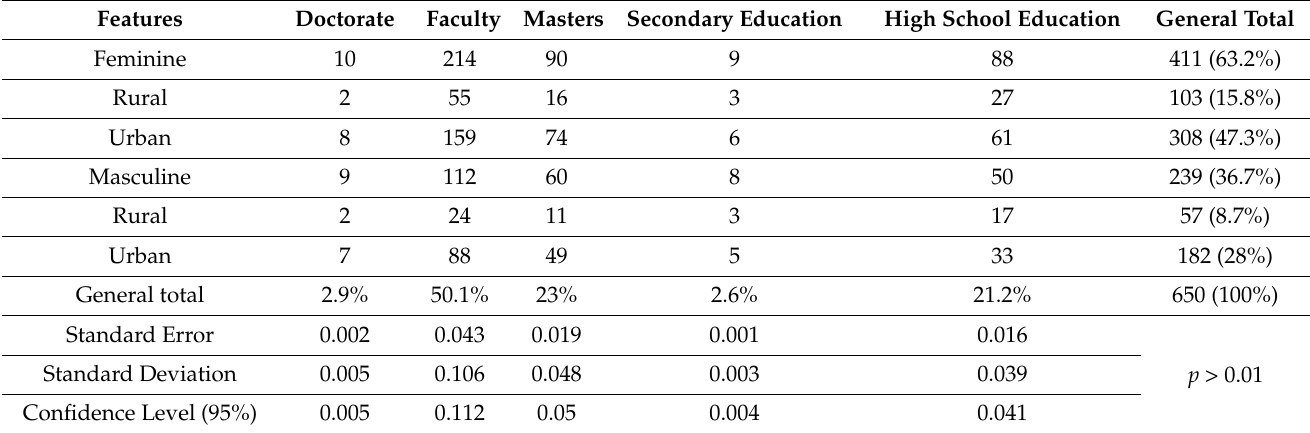
Table 1. Representation of the characteristics of the survey participants.